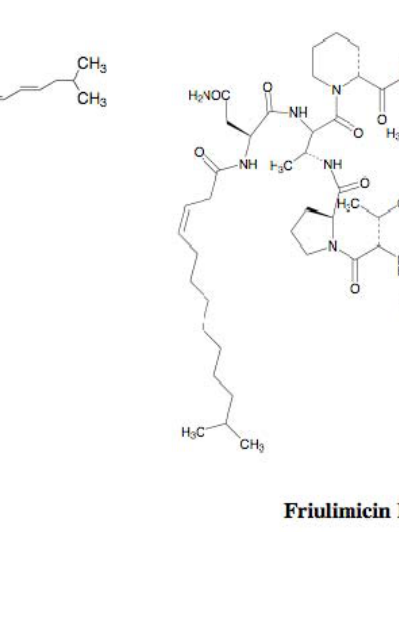
Figure 4. Structures of ramoplanin A2 and friulimicin